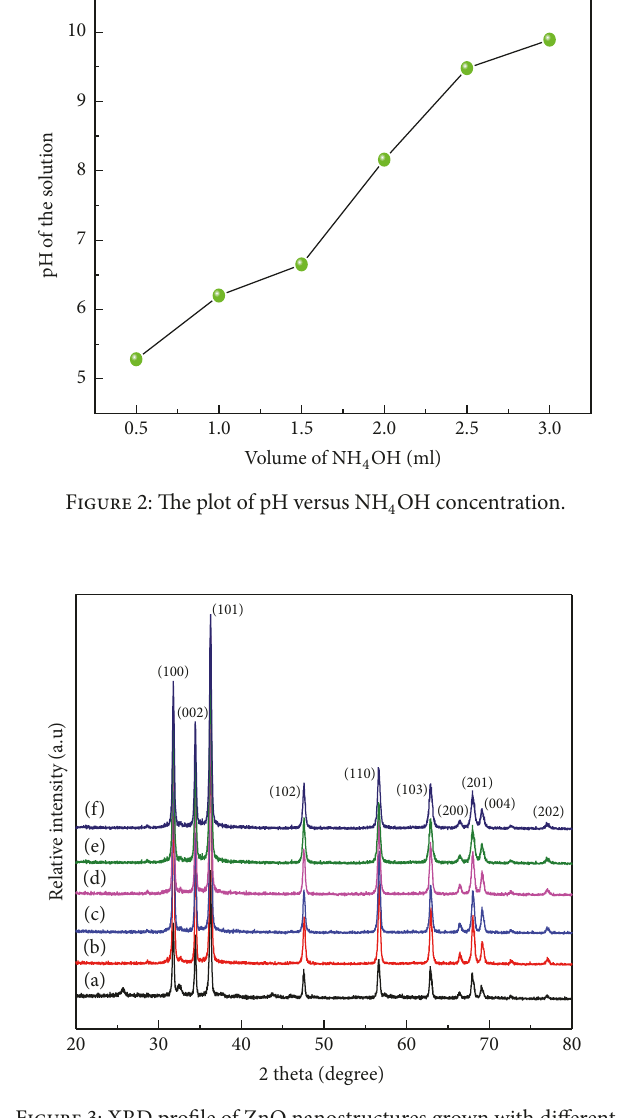
Figure 3: XRD profile of ZnO nanostructures grown with different NH 4 OHconcentrationsof(a)0.1 ml,(b)0.5 ml,(c)1.0 ml,(d)2.0 ml, (e) 2.5 ml, and (f) 3